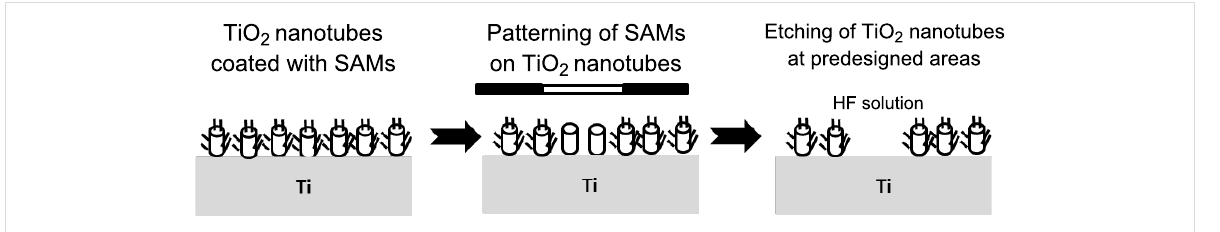
Figure 7: Patterning of a surface containing TiO 2 nanotubes by localized etching, by using patterned SAMs to protect selected areas (after